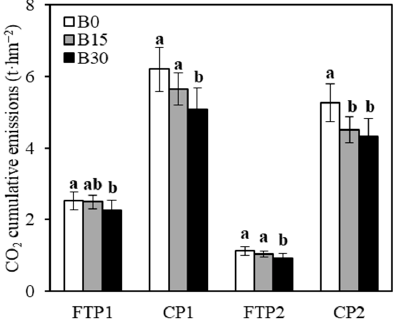
Figure 3. Effect of biochar addition on annual soil respiration rate in saline soil. (Note: Different lowercase represents significant difference at p < 0.05 between treatments).